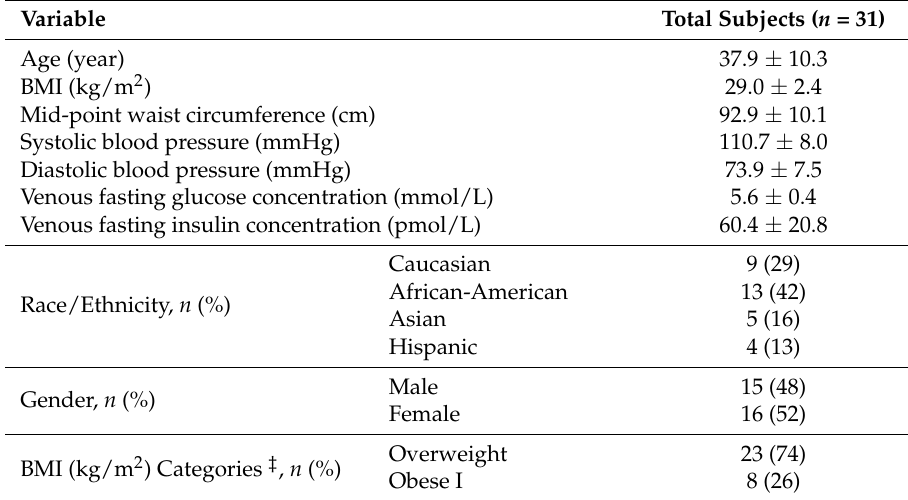
Table 3. Demographic information (Mean ± SD) * ,† .